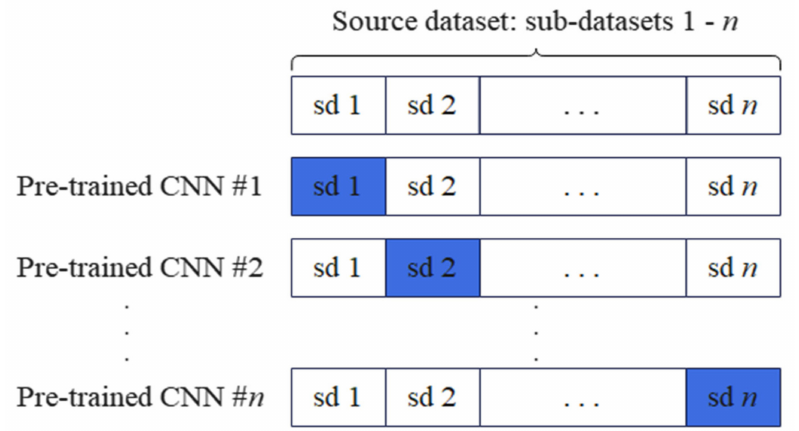
Figure 7. Illustration of splitting the source dataset into n -fold for pretraining n NN